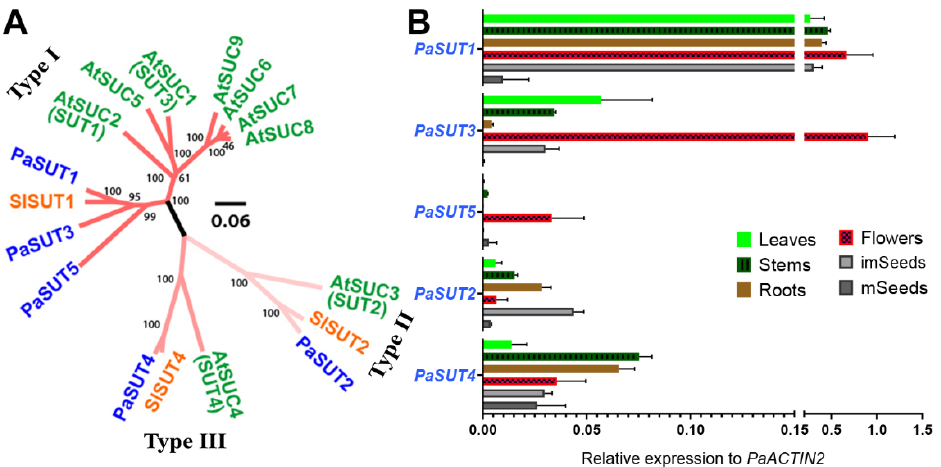
Figure 1. Phylogenetic analysis and tissue-specific expression profile of the P. axillaris SUT / SUC sugar transporters. ( A ) The 5 SUT / SUC sequences fall into three groups, representing the type I, Type II and Type III members. PaSUTs are shown in blue. Arabidopsis thaliana orthologs are in green: AtSUC1, At1g71880; AtSUC2, At1g22710; AtSUC3, At2g02860; AtSUC4, At1g09960; AtSUC5, AT1G71890; AtSUC6, AT5G43610; AtSUC7, AT1G66570; AtSUC8, AT2G14670; AtSUC9, At5g06170. Solanum lycopersicum orthologs are in orange: SlSUT1, NP_001289830.1; SlSUT2, NP_001234321.2; SlSUT4, NP_001234344.2. Sequence alignment and analysis are conducted using MUSCLE with default parameters, and the phylogenetic tree is constructed with MEGA X version 10.1.8 using the neighbor-joining (NJ) method with 1000 bootstrap replications. The tree is graphed via Figtree version 1.4.4, with bootstrap value greater than 50% shown. The scale bar represents the ammino acid substitution rate per site. ( B ) Tissue-specific gene expression analysis of the SUT / SUC genes via quantitative real-time PCR. Data are mean of 3 biological replications with the error bars representing SD.